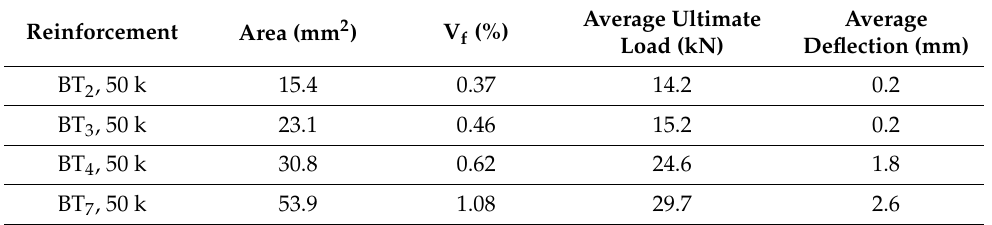
Table 5. The effects of rovings at the same layer on the ultimate loads and deflections of TRC beams.